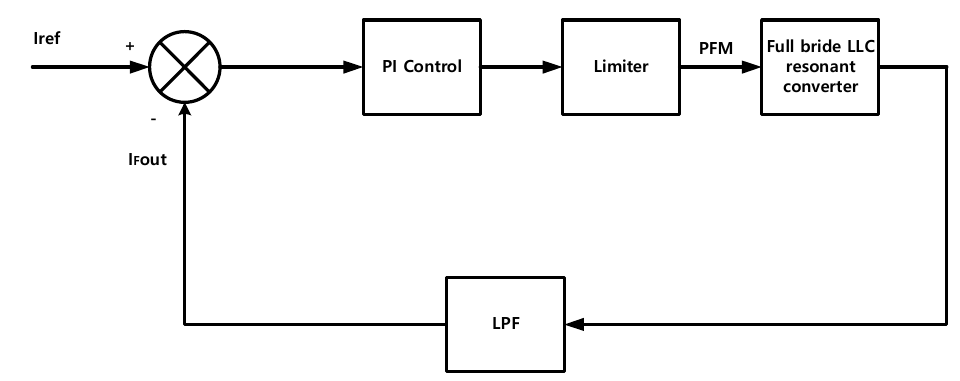
Figure 8. The proposed block diagram of CC (the SC case).